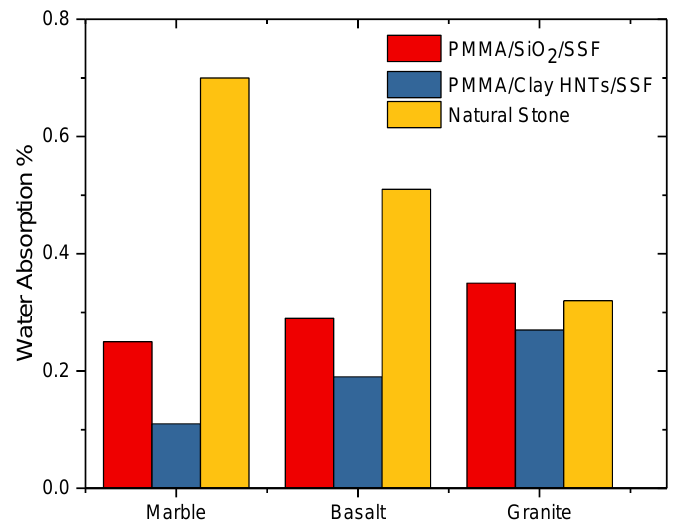
Figure 8. Effect of nanofiller types on the water absorption of acrylic solid surface nanocomposite sheets.